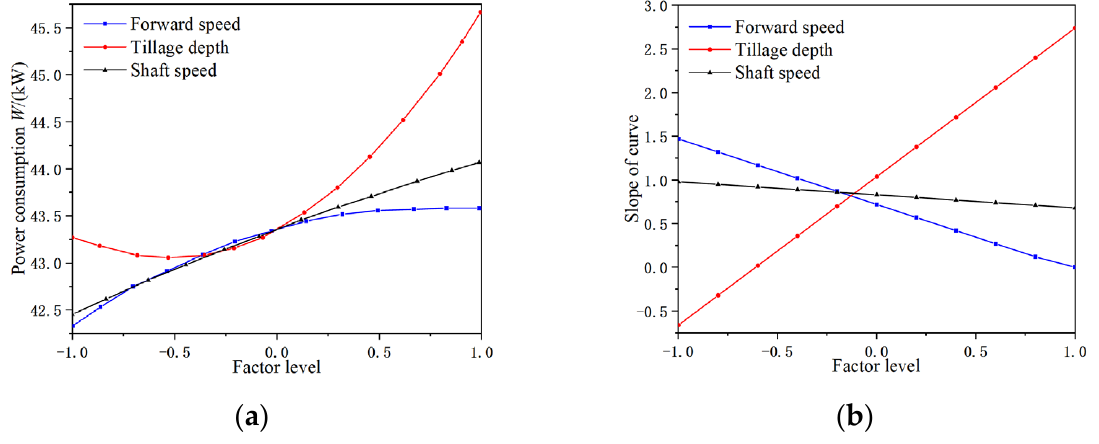
Figure 19. Single-factor effect of power consumption. ( a ) Submodel regression curve; ( b ) slope of the factor curve.